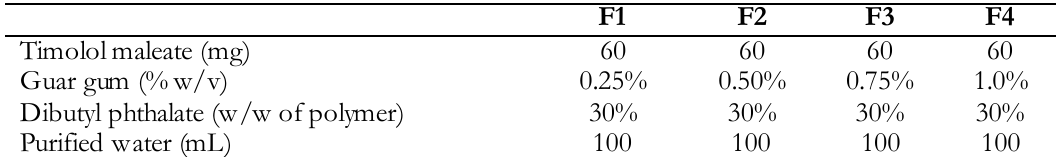
Table I. Composition of polymeric matrices for the different formulation